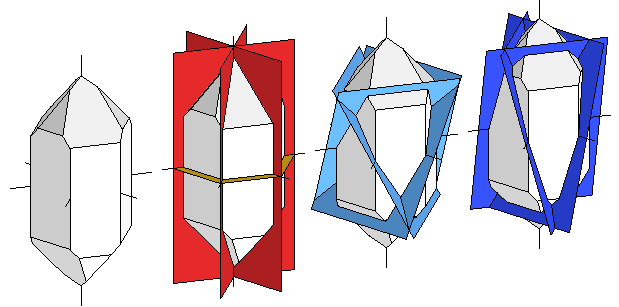
Fig. 5 | Schematic depiction of the orientation of the (0001) plane of the metastable high-pressure phase with respect to the quartz crystal with its a and c axes. The orientation of this plane has been inferred from the indexing